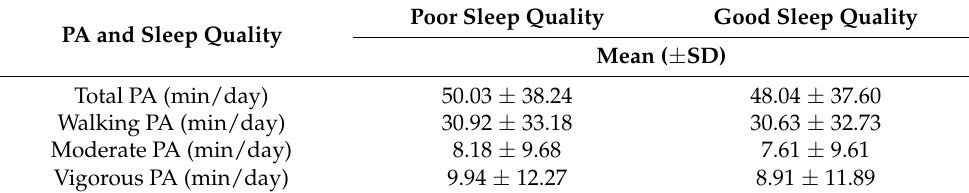
Table 5. Time of physical activity according to the quality of sleep in the study population ( n = 1956).